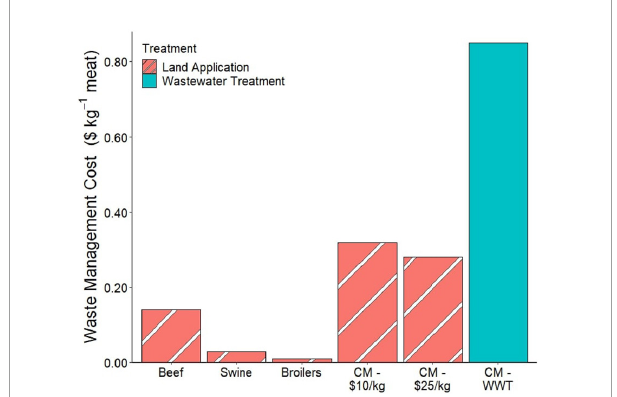
FIGURE4 Costs of nutrient management strategies for conventional meat production, two CM scenarios for land application, and CM wastewater treatment (WWT) for COD and